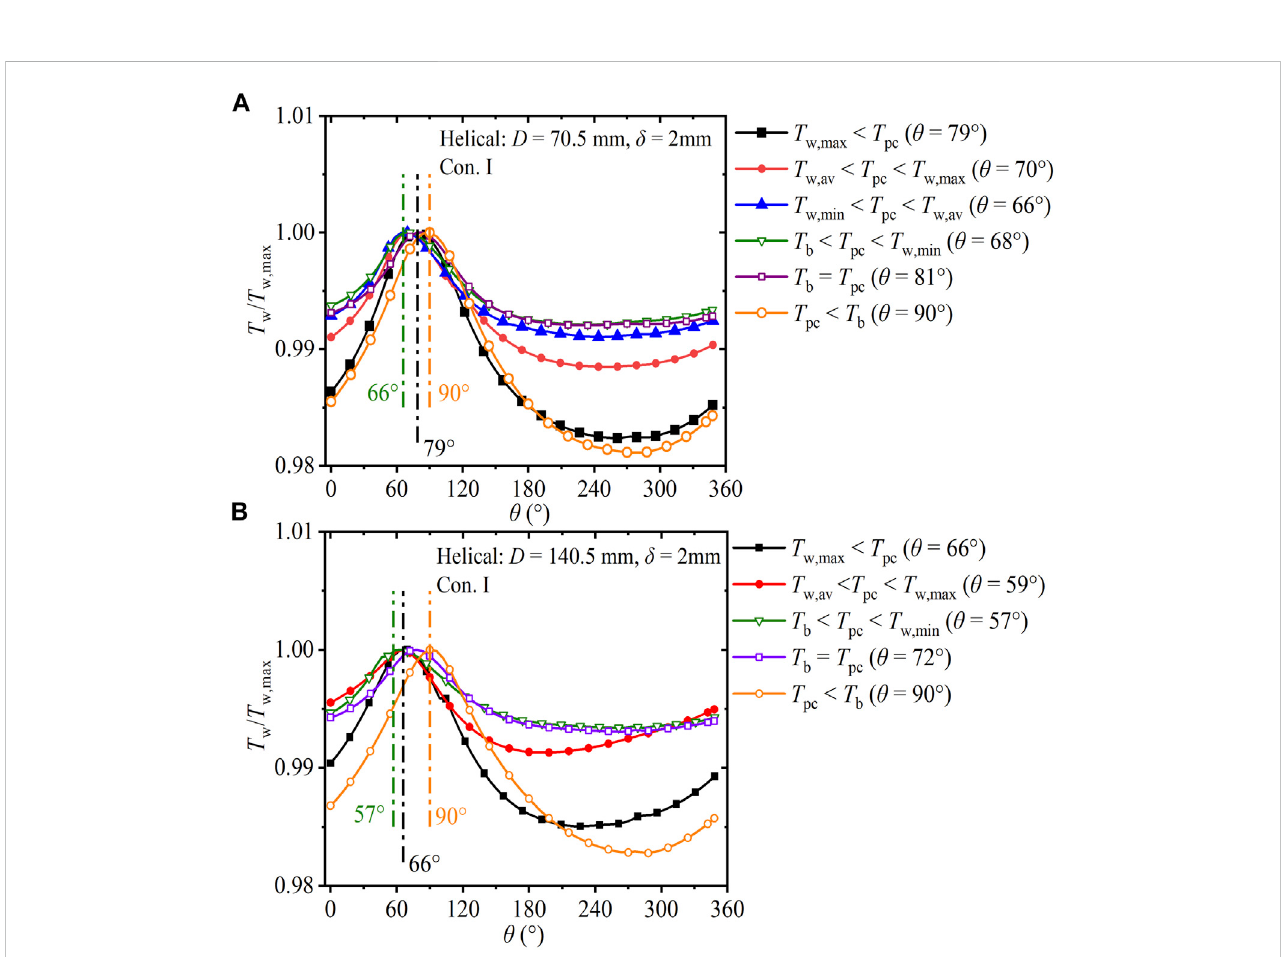
FIGURE 14 Development of circumferential T w / T w,max in helical tubes versus θ ( δ = 2 mm, Con. I: G in = 225 kg). (A) D = 70.5 mm; (B) D = 140.5